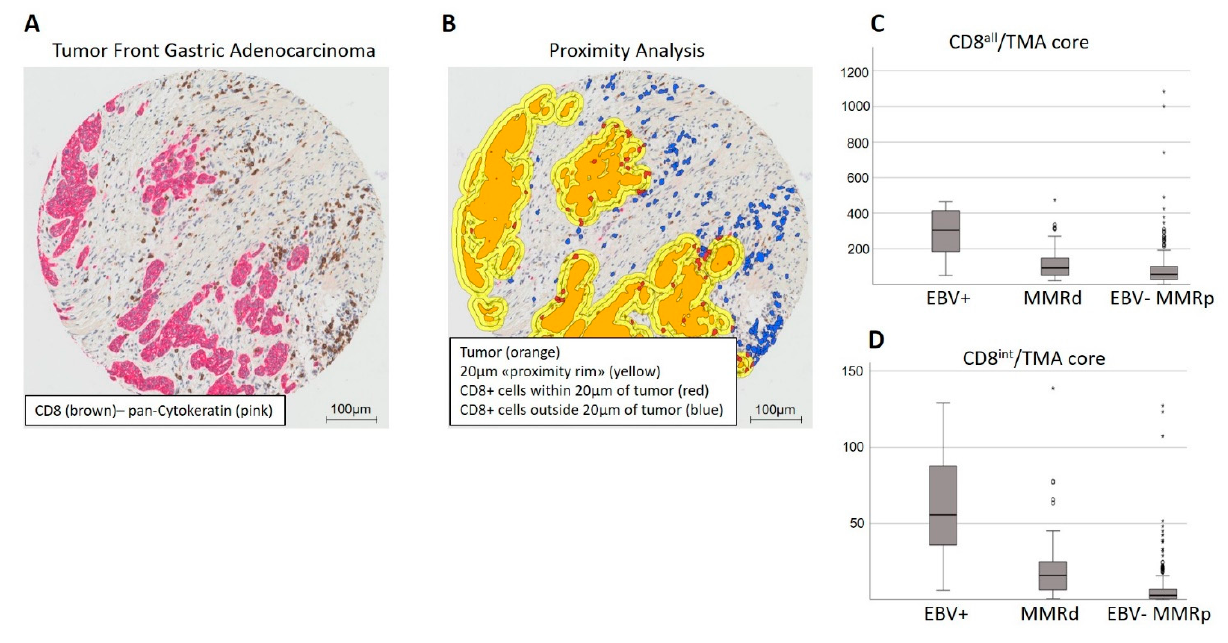
Figure 1. Digital image analysis of intra- and peritumoral CD8+ lymphocytes. ( A ) Double immunohistochemistry of a TMA core of gastric cancer. ( B ) Digital overlay of the same core after analysis, demonstrating the accuracy of cell detection and tumor boundary. ( C ) Box plots demonstrating the distribution of all intraepithelial and peritumoral (CD8 all ) or ( D ) only intratumoral (CD8 int ) CD8+ lymphocytes per TMA core amongst the different GC subtypes. The circles and stars in ( C ) and ( D ) represent outliers. Circles represent outliers above the upper limit of quartile 3 by a factor of 1.5 times the interquartile range. Stars represent outliers above the upper limit of quartile 3 by a factor of 3 times the interquartile range.